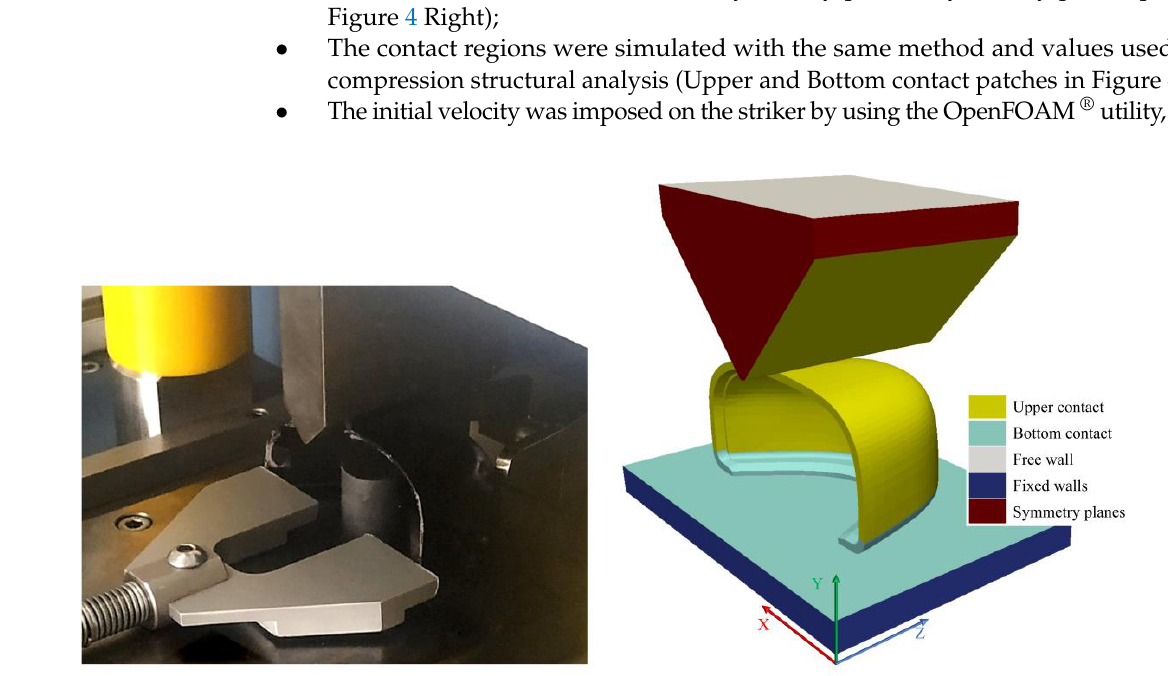
Figure 4. Impact test setup for the safety footwear toe cap: experimental configuration ( left ), computational model with the indication of the boundary patches ( right